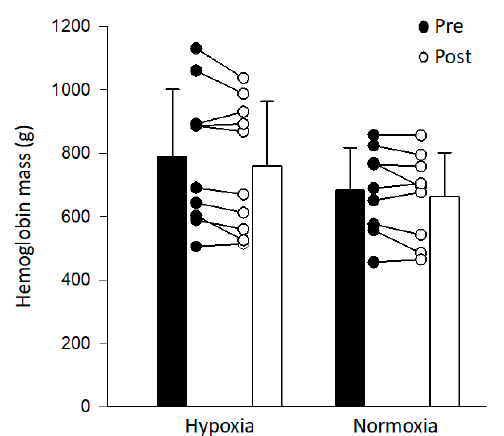
Figure 2. Average and individual hemoglobin mass before (pre; black bars) and 7 days following exposure to intermittent hypoxia or intermittent normoxia (post; white bars). Table 4. Hematological variables before and after intermittent hypoxia and intermittent normoxia. Hypoxia Normoxia Variable Pre Post Pre Post